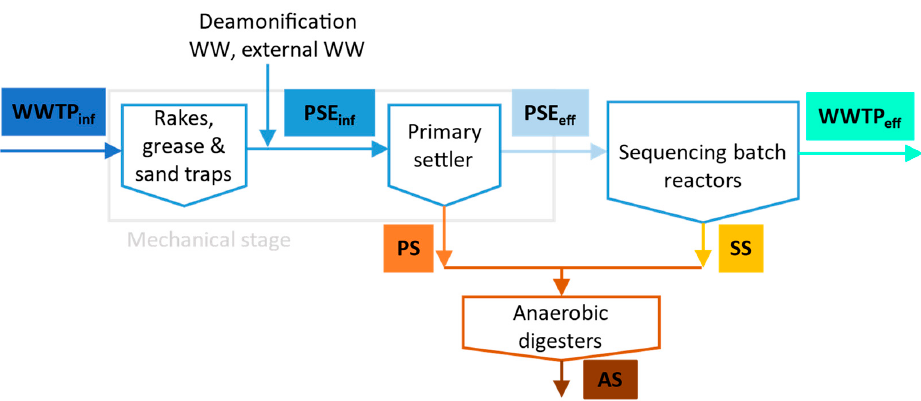
Figure 1. Scheme of the sampling, where sampling points and names of the samples are in colored squares.